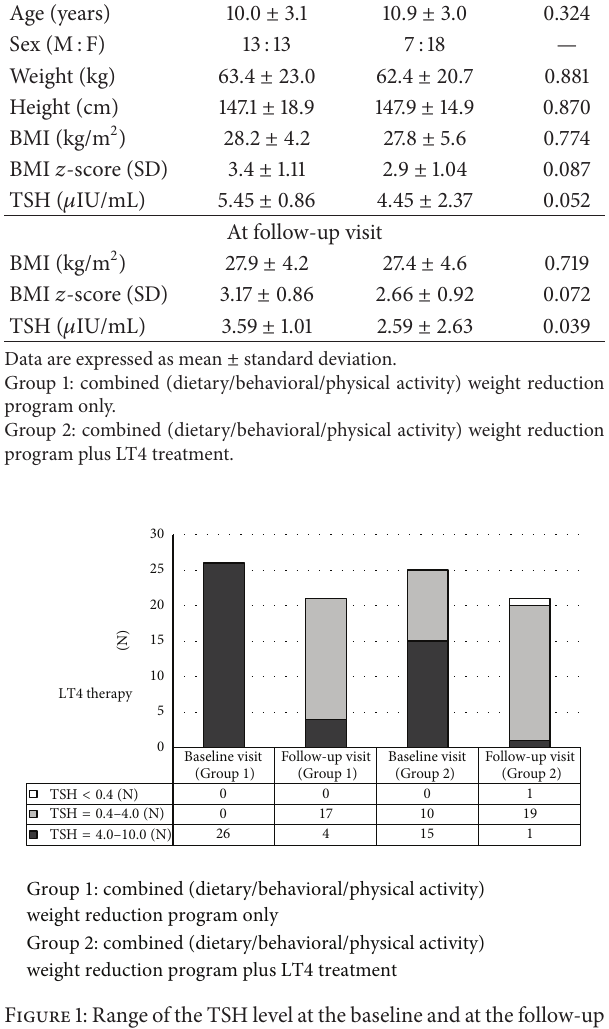
Figure 1: Range of the TSH level at the baseline and at the follow-up